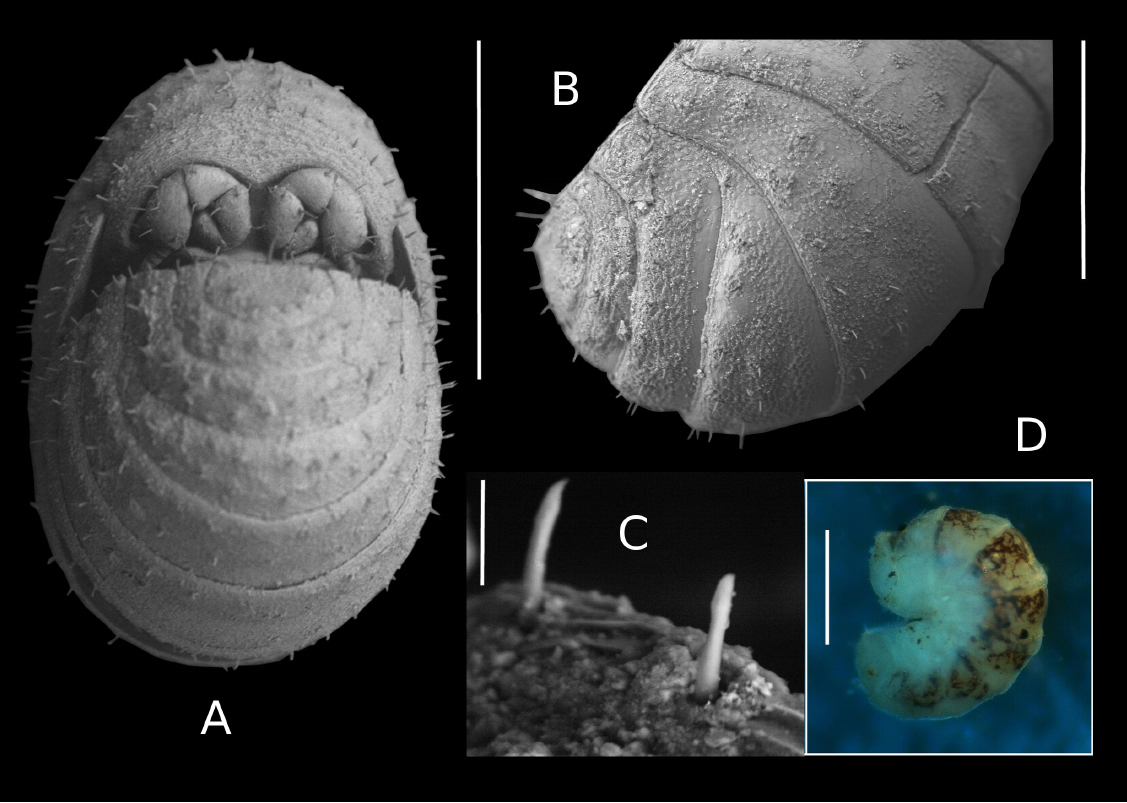
Fig. 3. Buchnerillo atlanticus sp. nov., ♀ (CLLG). A . Whole animal, partially conglobated. B . Last pereonites, pleon and pleotelson, lateral view. C . Tergal setae. D . Short time preserved specimen in lateral view. Scale bars: A, D = 0.5 mm; B = 0.3 mm; C = 0.015